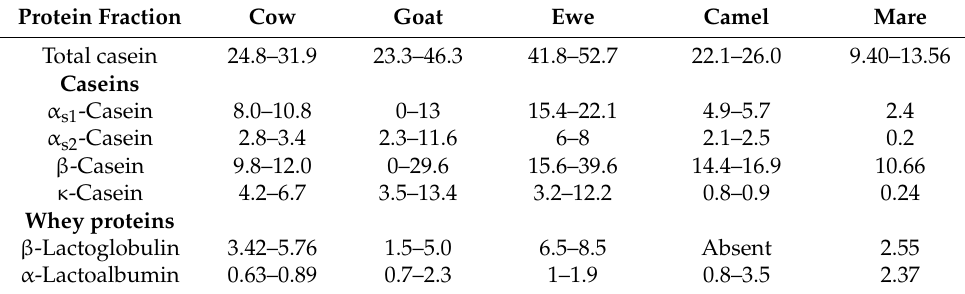
Table 5. Protein profile (g/L) of milk from different mammalian species. Protein Fraction Cow Goat Ewe